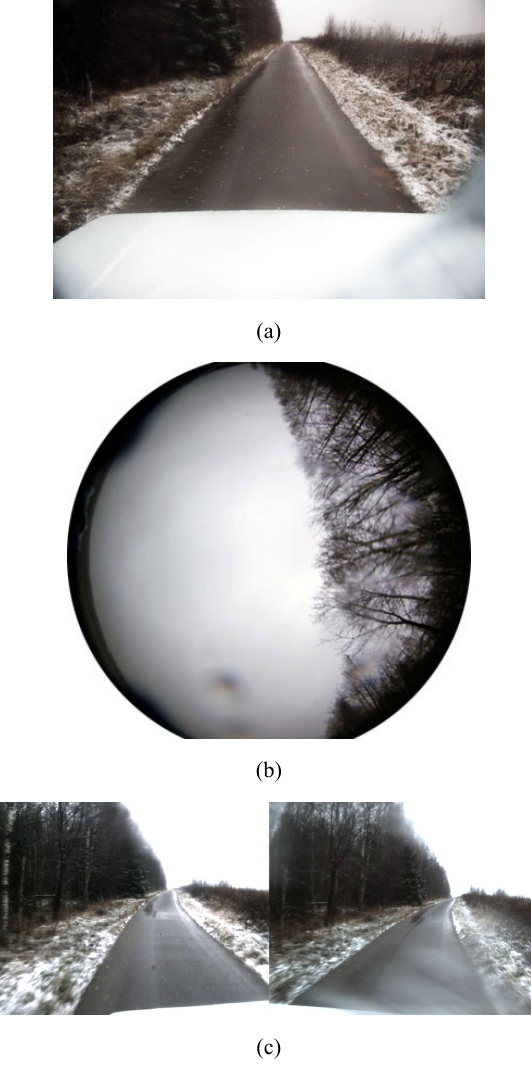
Figure 3 . Examples of fields of view of the recording units: (a) mono camera looking into a given area of space; (b) an omnidirectional camera with a fisheye lens; (c) forward looking stereo